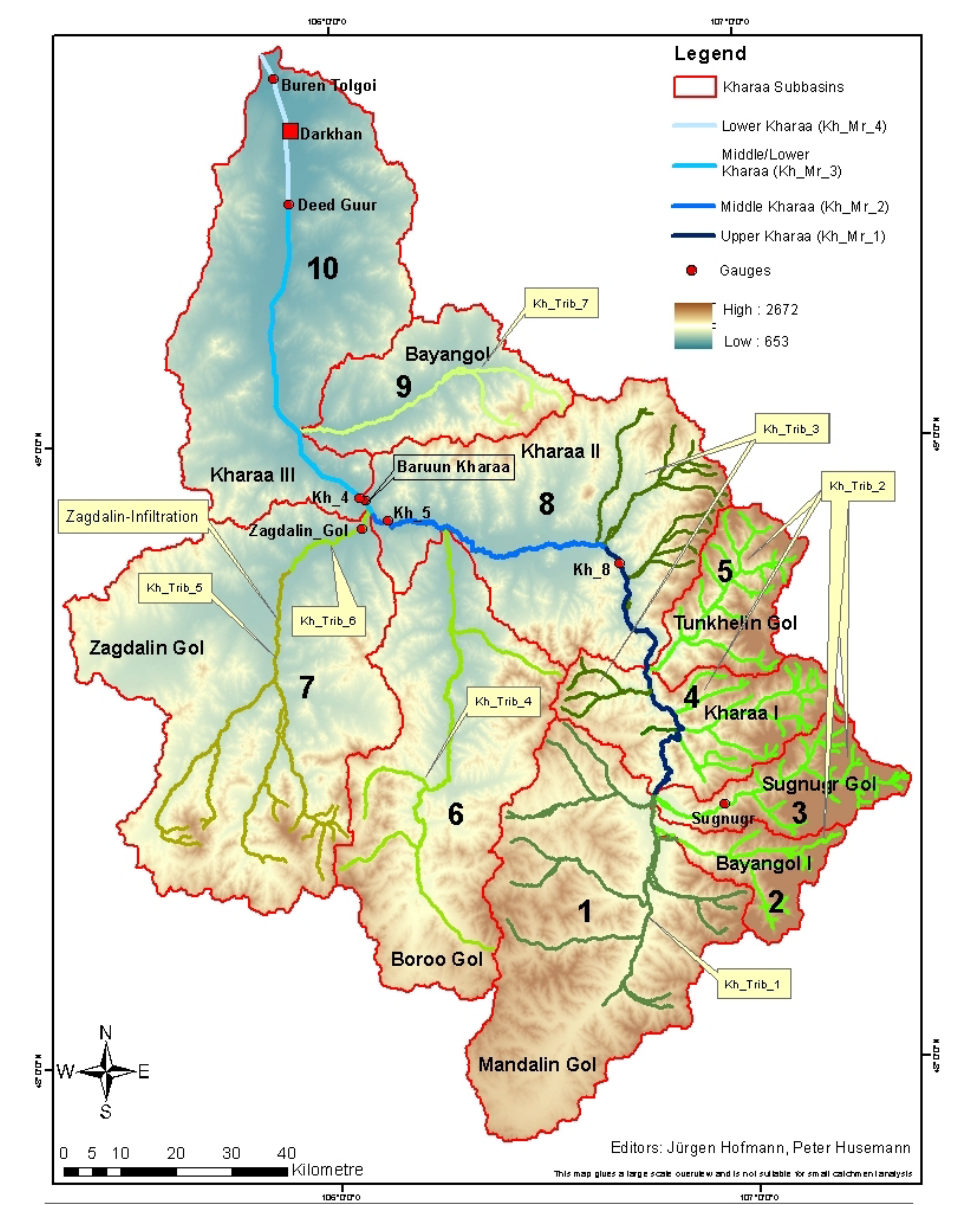
Figure 4. Description of surface water bodies, location of monitoring sites and delineation of the KRB into 10 sub-basins (No.